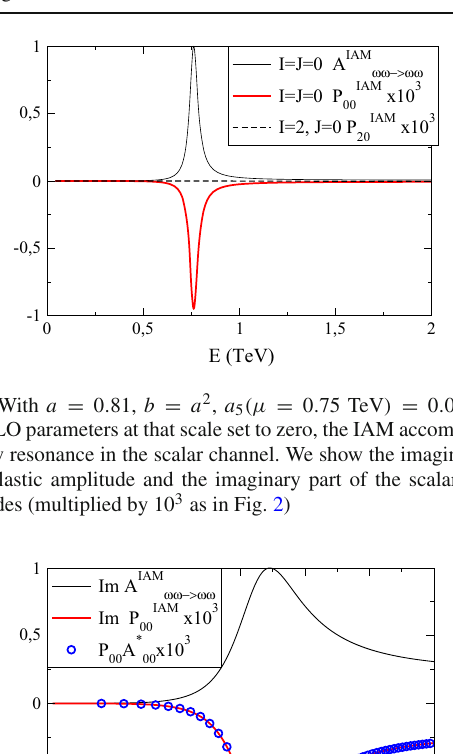
Fig. 6 Dependence of the P 00 amplitude from Fig. 4 on ( a 1 − a 2 + a 3 ) (values thereof are given in the